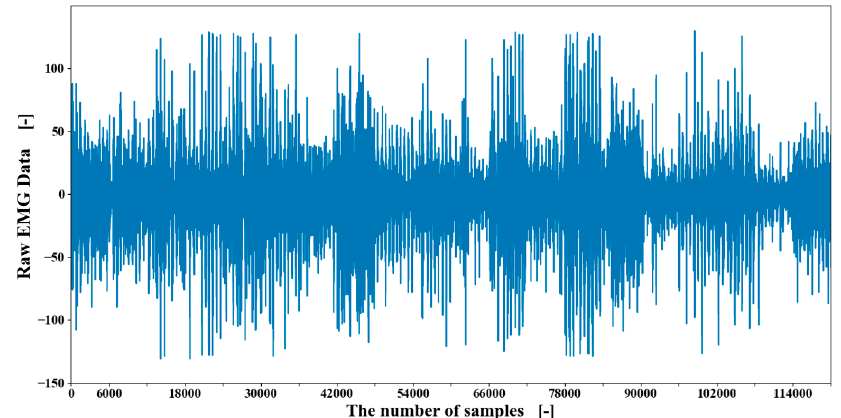
Figure 10. The obtained raw EMG data of 20 motions of participant one (10 times repeating for each motion).